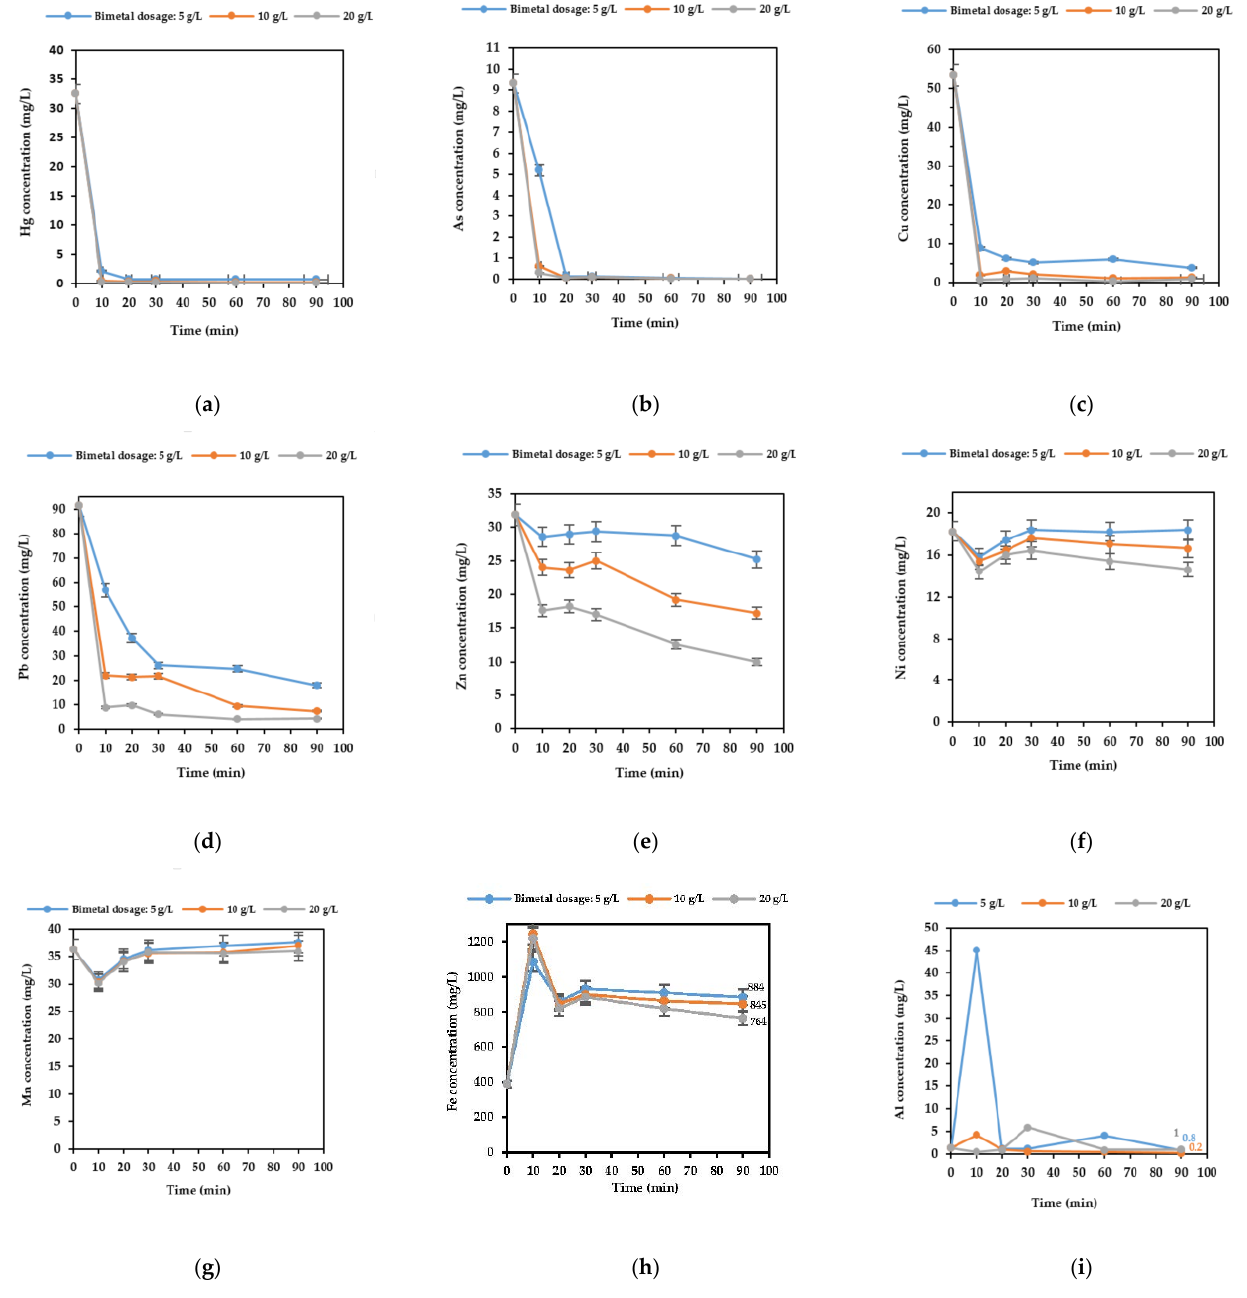
Figure 6. Variation of residual metal concentrations ( a ) As, ( b ) Hg, ( c ) Cu, ( d ) Pb, ( e ) Zn, ( f ) Ni, ( g ) Mn, ( h ) Fe, and ( i ) Al over time at different bimetal dosage (5, 10, and 20 g/L) and initial pH of 2.